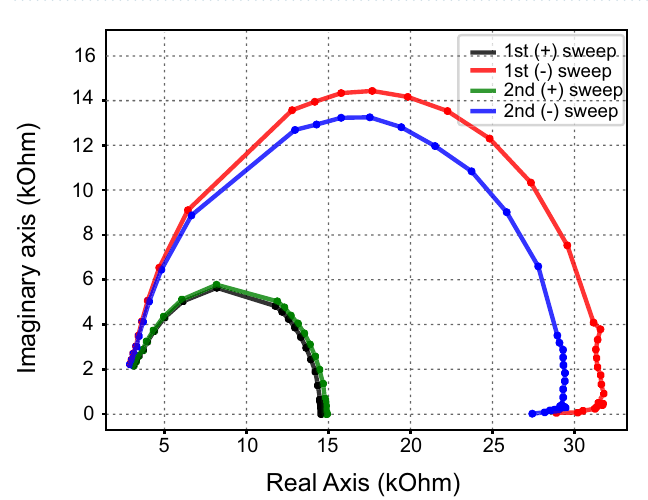
Figure 6. Subfigure ( a ) shows a simulated spectrum of a device with variable capacitance, according to the equivalent model shown in the inset, based with previous results received by our group for metal-oxide memristors. Subfigure ( b ) shows a simulated device with variable inductance, according to the RLC inset, where a variable inductance leads to a shift in the resonant peak.